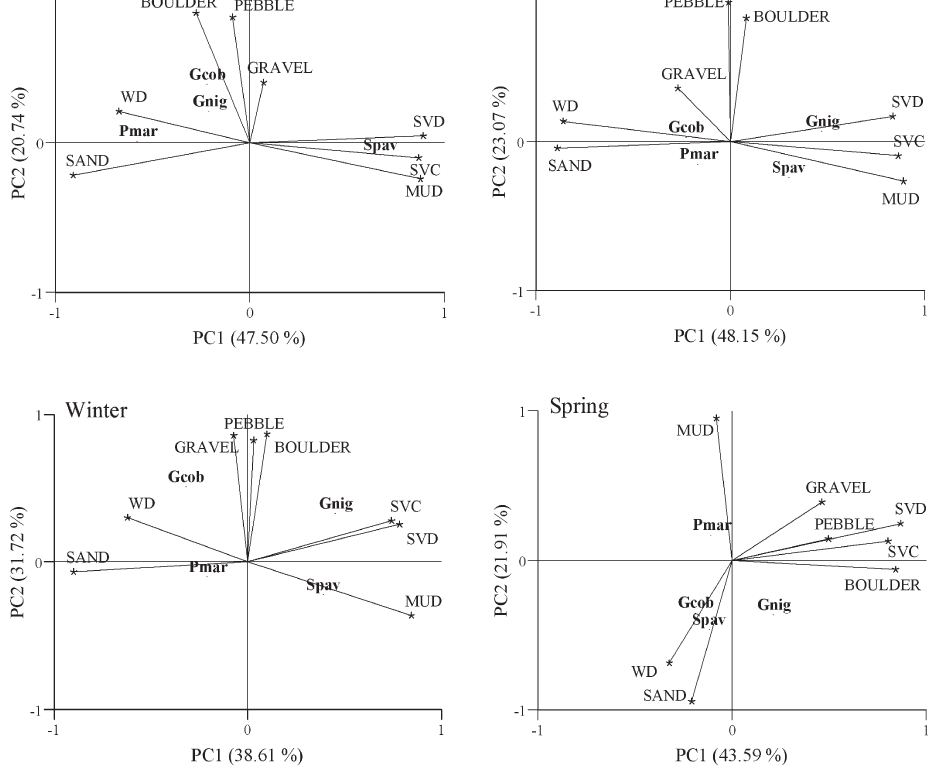
Fig . 5. − Results of the principal component analysis (PCA) and the position of studied species according to PCA scores. WD, water depth; SVC, submerged vegetation cover; SVD, submerged vegetation density; MUD, mud percentage; SAND, sand percentage; GRAVEL, gravel percentage; PEBBLE, pebble percentage; BOULDER, boulder percentage; Spav, Salaria pavo ; Pmar, Pomatoschistus marmoratus ; Gcob, Gobius cobitis ; Gnig, Gobius niger